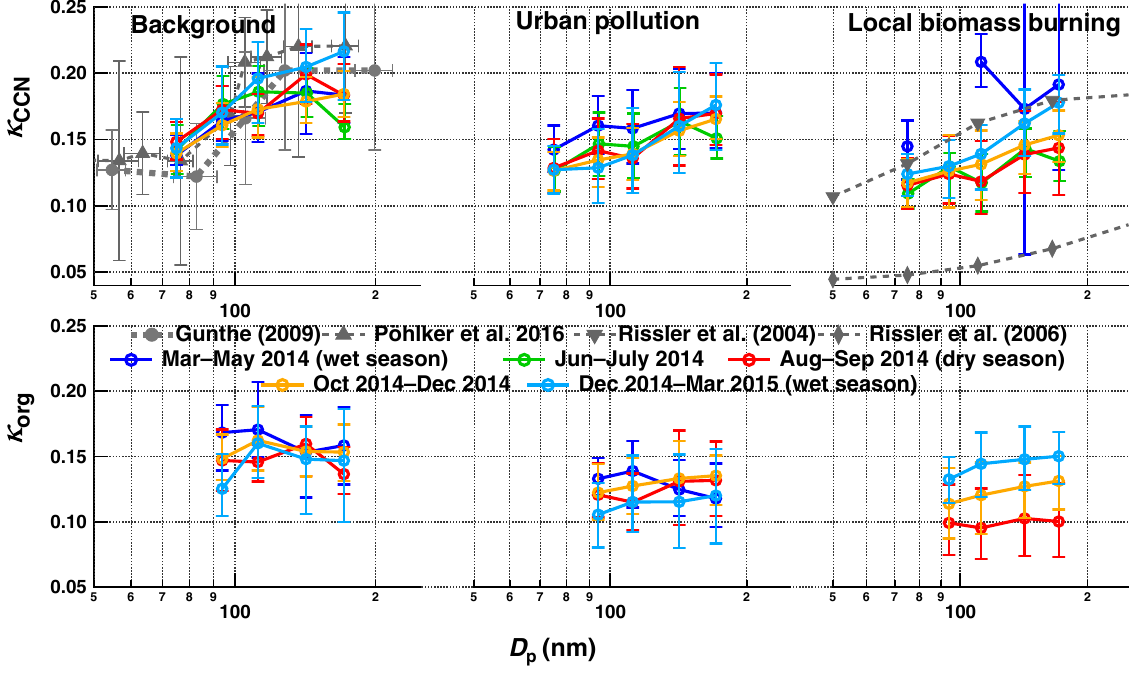
Figure 2. The variation of κ CCN and κ org with particle diameter during different seasons for each of three air mass types. Data points are the mean values; error bars are the 25th and 75th percentiles. The top-left panel also includes κ CCN observed under near-natural conditions during the AMAZE-08 campaign at T0t in the wet season (Gunthe et al., 2009) and during the 1-year period from March 2014 to February 2015 at the background T0a site (Pöhlker et al., 2016). The top-right panel includes κ derived from particle growth factor measurements in July 2001, during a “recent biomass burning period” of the CLAIRE-2001 study (Rissler et al., 2004), and from 11 September to 8 October 2002, during the dry period of the LBA–SMOCC (Rissler et al.,